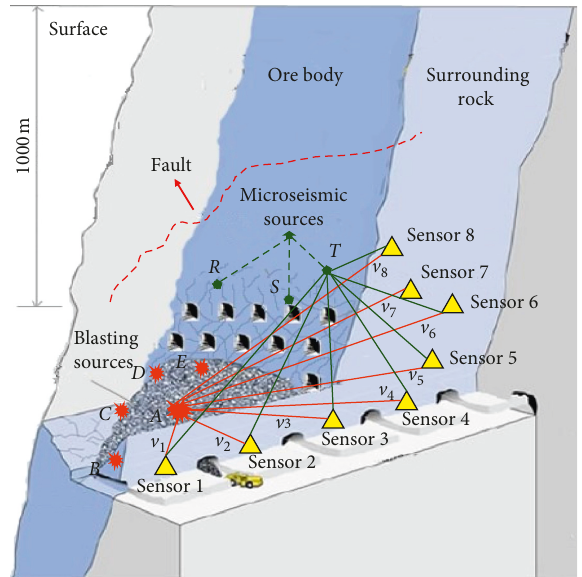
Figure 1: Graph shows the microseismic events, blasting events, and monitoring sensors in a mine. In the localization method that requires premeasured velocity, the average wave velocity is pre- measured through the blasting events. However, the propagation paths are different for the blasting events and the microseismic events located at different coordinates. Due to the difference of rock mass structure, the values of wave velocity will not be the same for different travel paths. Therefore, it is inaccurate to use the average velocity premeasured through the blasting events to locate the future microseismic event, where the velocity is different from the premeasured velocity (from